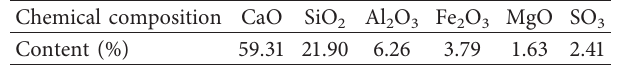
Table 1: Chemical composition of Portland